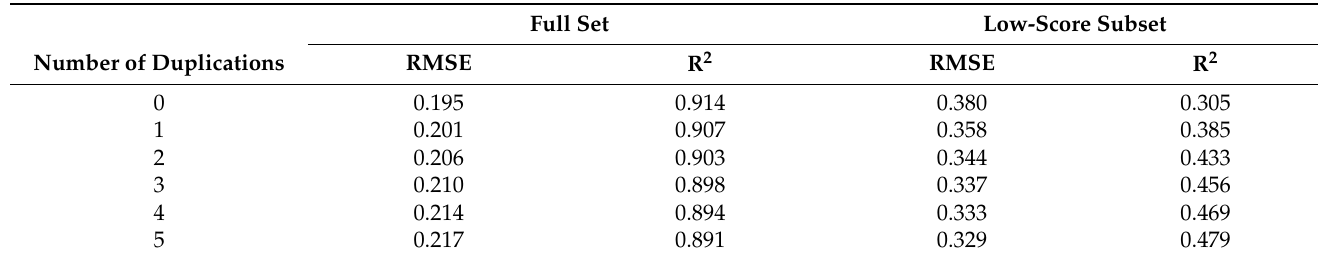
Table 4. RMSE and R 2 values for the XGBoost regression model for the full data set and the low-score subset with 0 to 5 duplications. Full Set Low-Score Subset